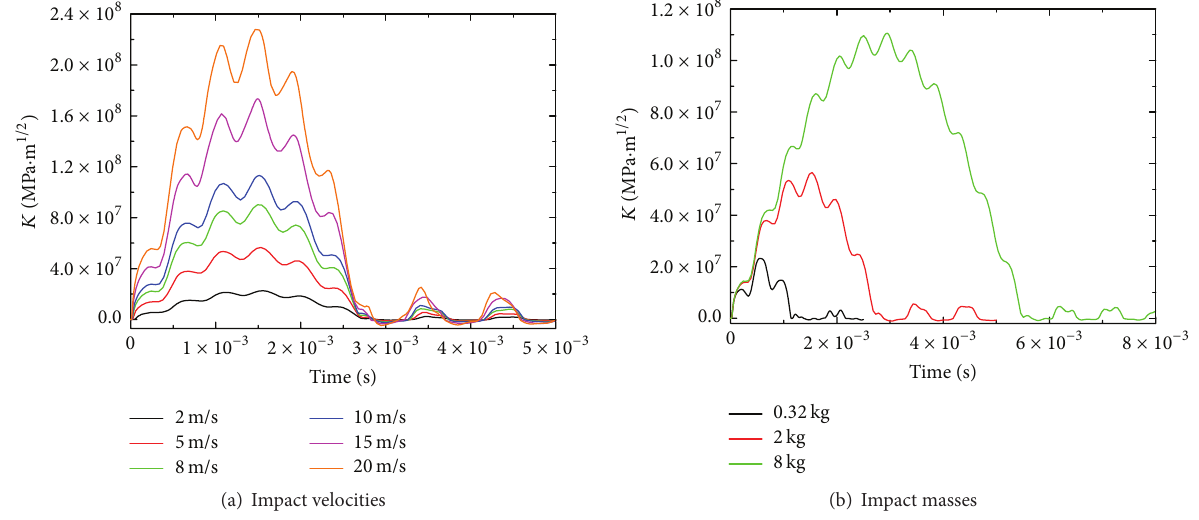
Figure 12: Mode I DSIF curves at node 1 with crack length of 0.02 m under different impact